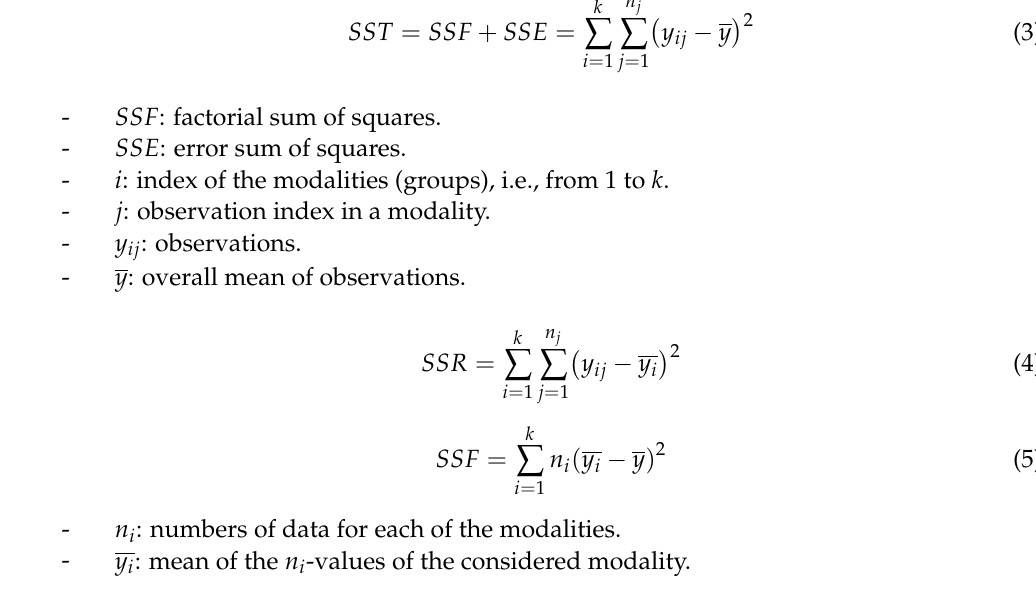
Table 2. Key elements of one-way ANOVA